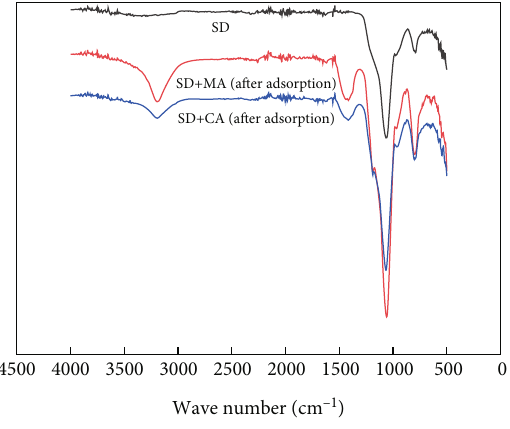
Figure 15: FT-IR spectra of SD, SD+ MA after adsorption, and SD +CA after